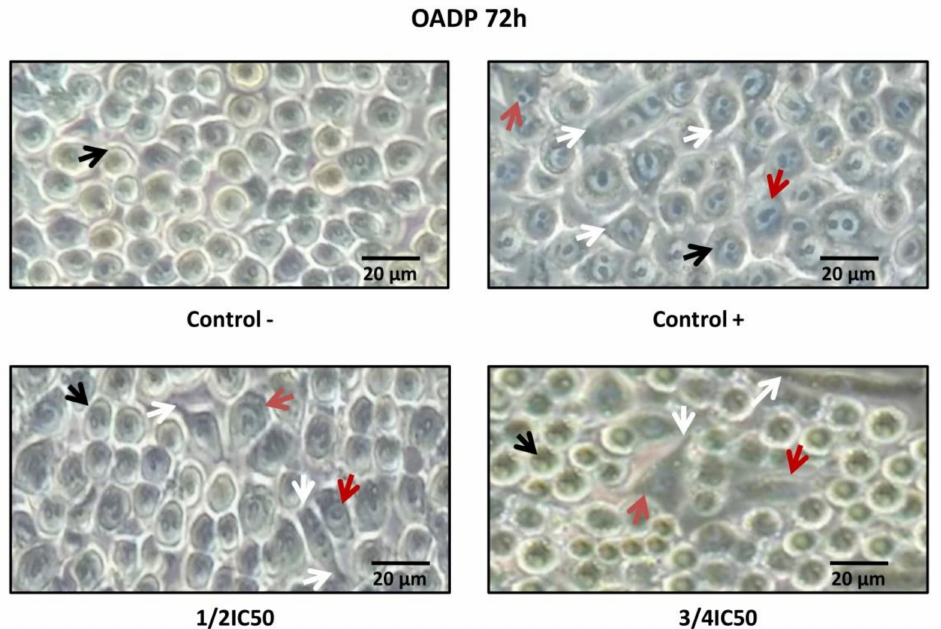
Figure 5. Morphological transformation in RAW 264.7 cells stimulated with LPS and OADP treatment for 72 h at the 1 IC 50 and 3 IC 50 concentrations. The black arrows indicate Raw 264.7 cells in 2 4 monocyte state. The red arrows indicate Raw 264.7 cells in macrophage state. The white arrows indicate cytoplasmic